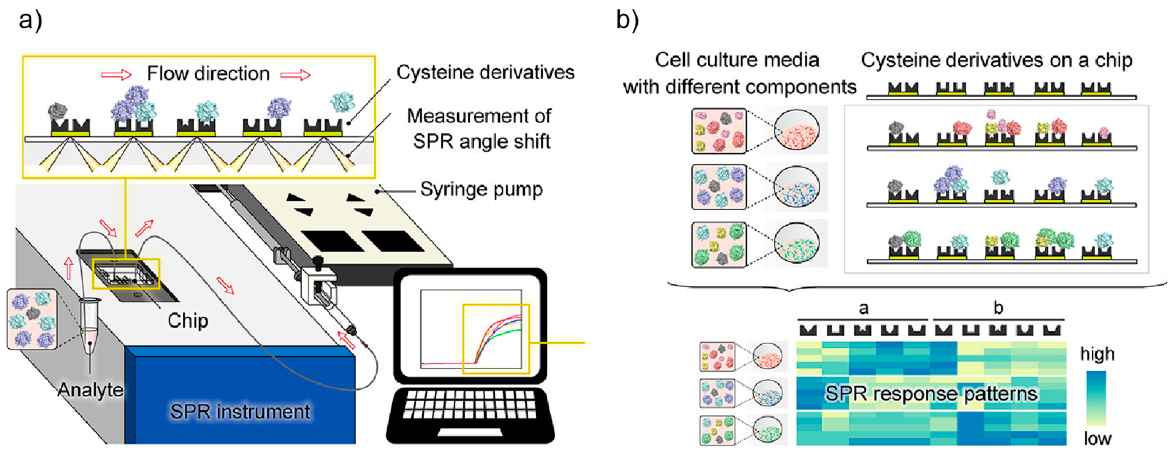
Figure 7. A multichannel SPR chip with immobilized cysteine derivatives for cell characterization. ( a ) Simultaneous acquisition of the SPR sensorgrams reflecting the interactions between cysteine derivatives on a chip and cell-secreted molecules. ( b ) Unique SPR response patterns resulting from cross-reactive interactions between cysteine derivatives and cell-secreted molecules. Reproduced with permission from [101]. Copyright 2020 American Chemical Society.